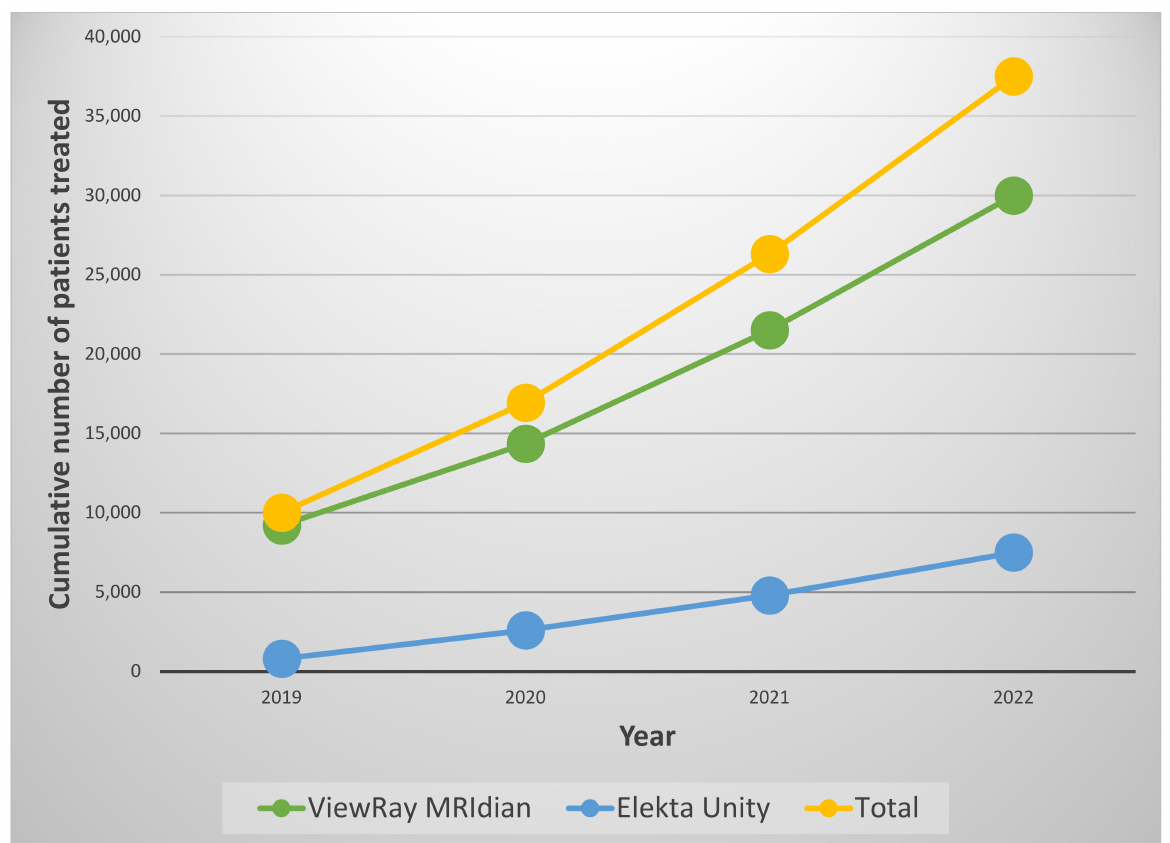
Figure 3. Cumulative treatments of ViewRay MRIdian and Elekta Unity MRLs per year since 2019. Data used for the creation of Figure 3 were directly provided by ViewRay and from data presented at the 9th annual MR in RT symposium